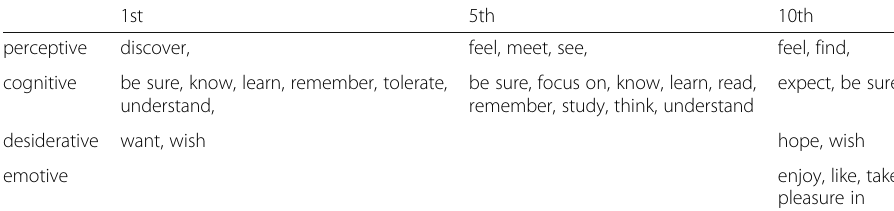
Table 6 Verbs that realize the Process in ‘ mental ’ clauses in students ’